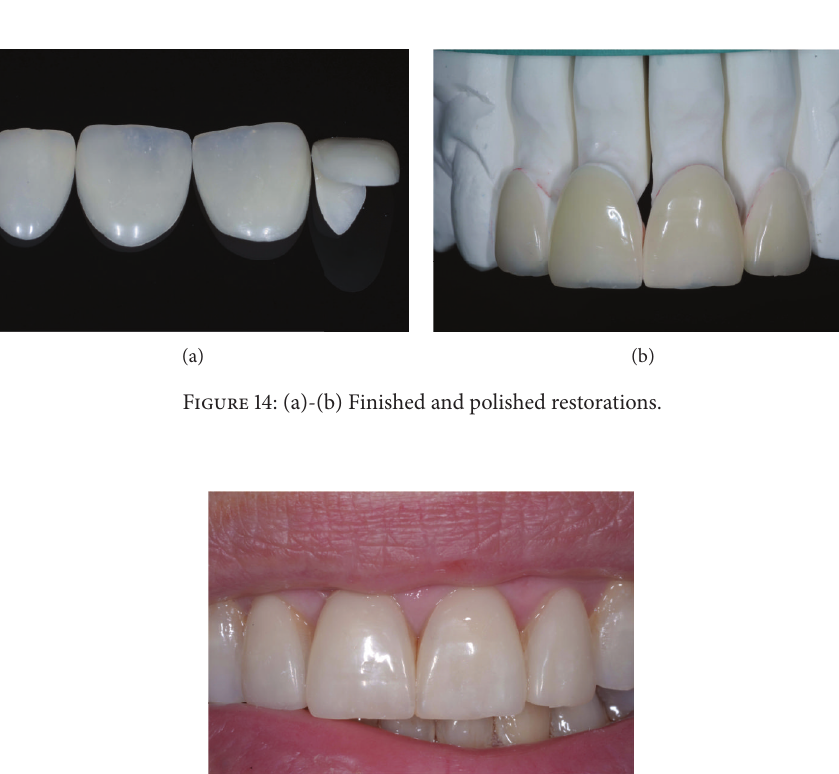
Figure 13: (a) Wax-up silicon index. (b) Microhybrid resin composite veneers fabrication.